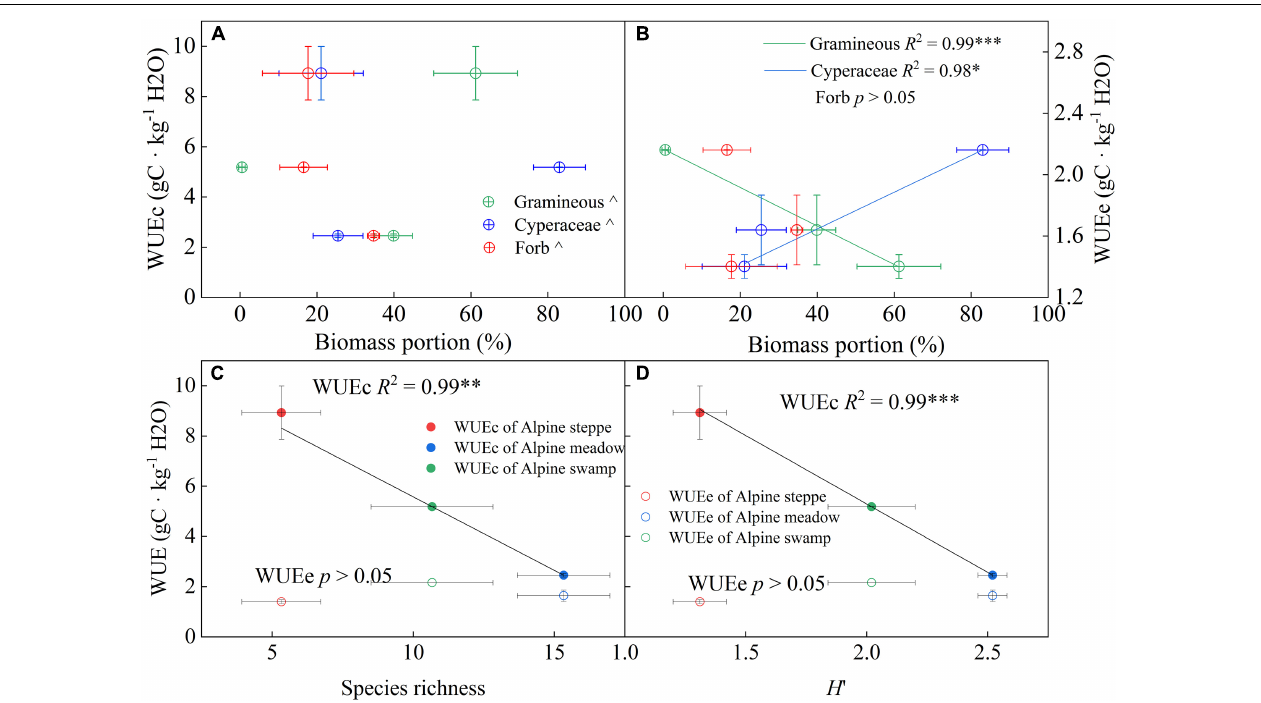
FIGURE 7 | Relationships between yearly WUEe and WUEc and (A) total biomass, (B) gramineous biomass proportion, and species diversity indices (C) species richness and (D) Shannon–Wiener diversity index ( H (cid:48) ) across the three alpine ecosystems. R 2 and probabilities of the regressions are shown. ˆ p > 0.05; ∗ p < 0.05; ∗∗ p < 0.01; ∗∗∗ p < 0.001. Error bars show the standard